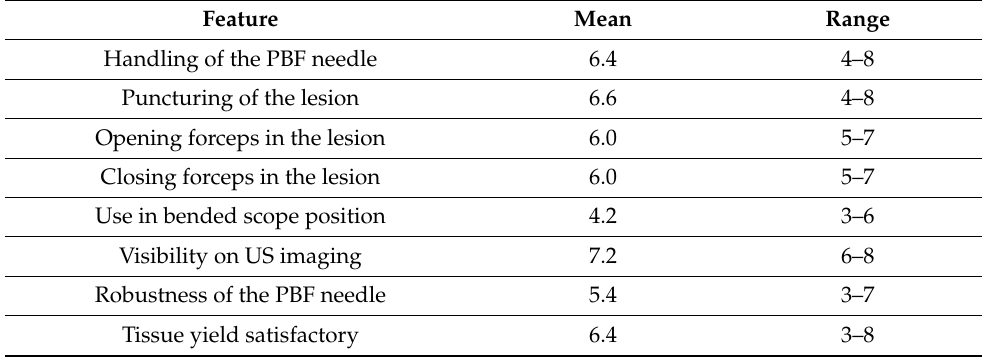
Table 4. Results of the questionnaire about user experience (1 lowest; 10 highest